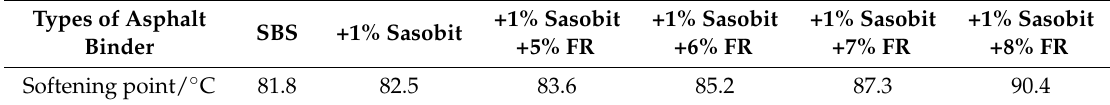
Table 5. Results of the softening point test.